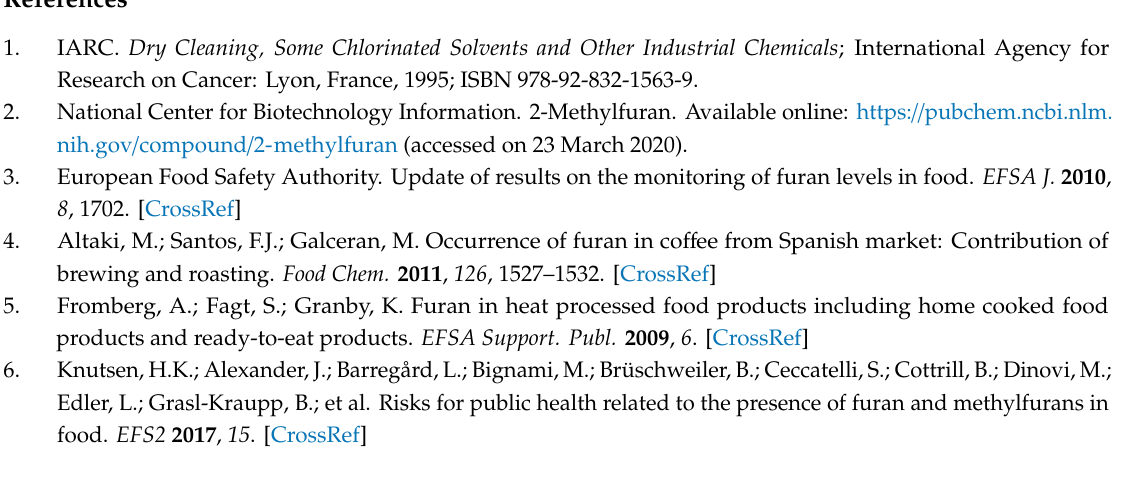
Figure S2: MS / MS spectrum of AcLys-BDA; Figure S3: MS / MS spectrum of GSH-BDA; Figure S4: MS / MS spectrum of AcCys(SO)-BDA-AcLys; Figure S5: MS / MS spectrum of AcCys-BDA-Lys; Figure S6: MS / MS spectrum of GSH-BDA-Lys; Figure S7: MS / MS spectrum of GSH-BDA-Gln; Figure S8: MS / MS spectrum of GSH-BDA-AcLys; Figure S9: MS / MS spectrum of CysGly-BDA-GSH; Figure S10: MS / MS spectrum of BDA-Lys-BDA; Figure S11: MS / MS spectrum of Lys-AcA; Figure S12: MS / MS spectrum of AcLys-AcA; Figure S13: MS / MS spectrum of AcCys-AcA; Figure S14: Urinary metabolites of